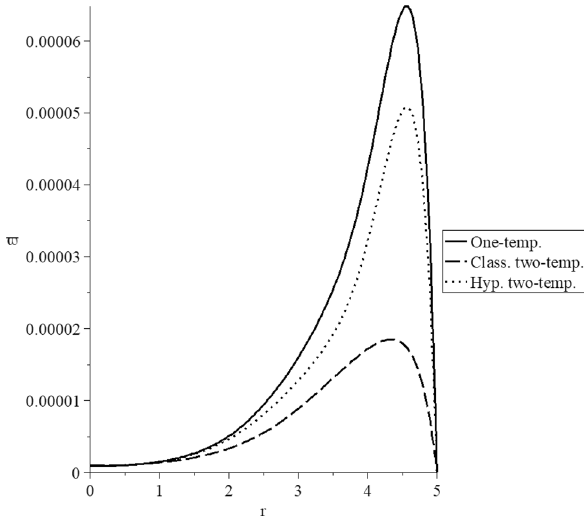
Figure 8. The stress-strain energy distribution for different